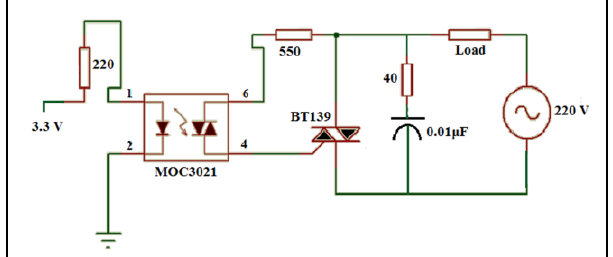
Figure 1. Circuit Diagram for TRIAC-based